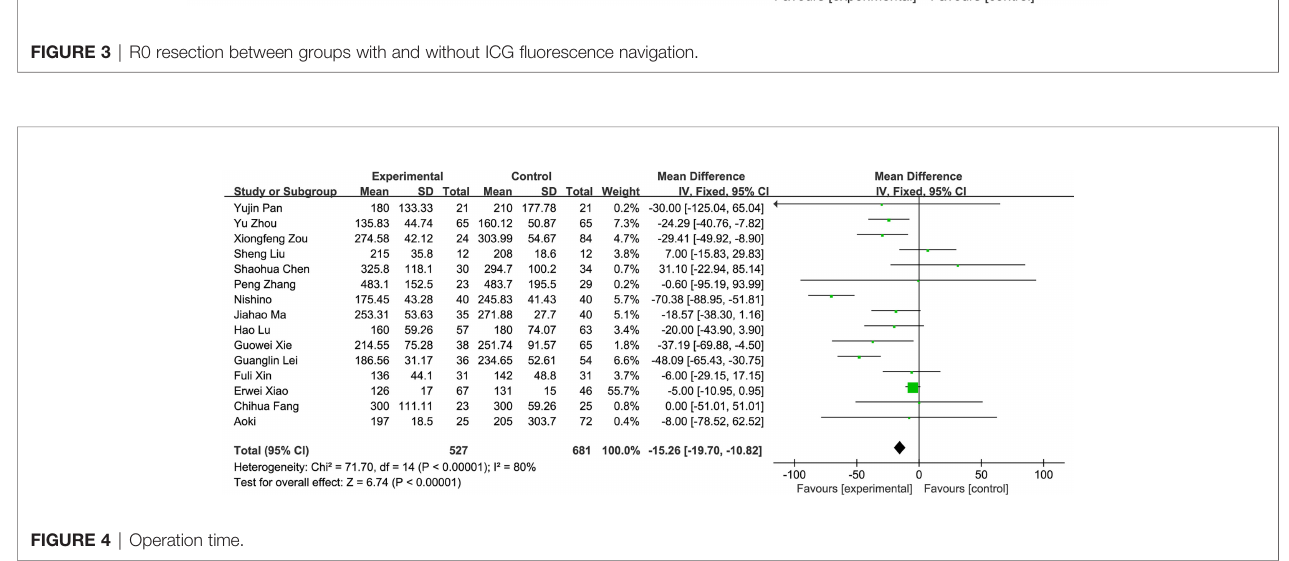
FIGURE 4 | Operation time.